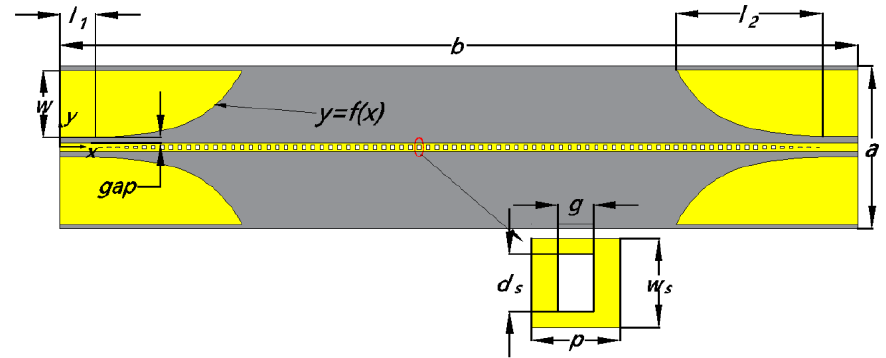
Figure 1. The geometry configuration of the SSPP transmission line.